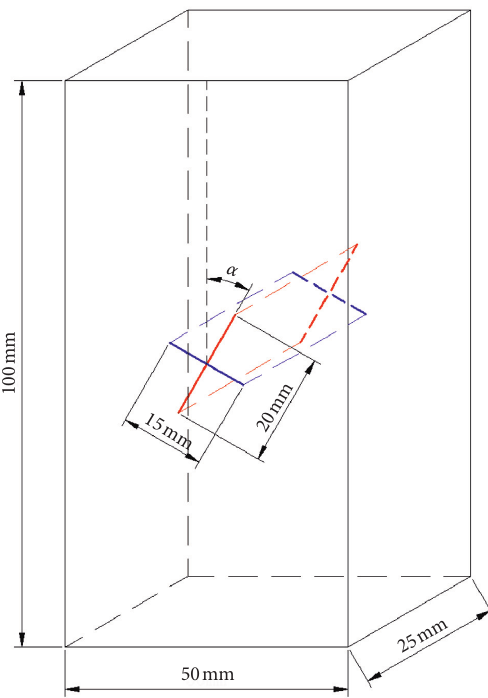
Figure 1: The location and geometry of the preexisting orthogonal cracks.